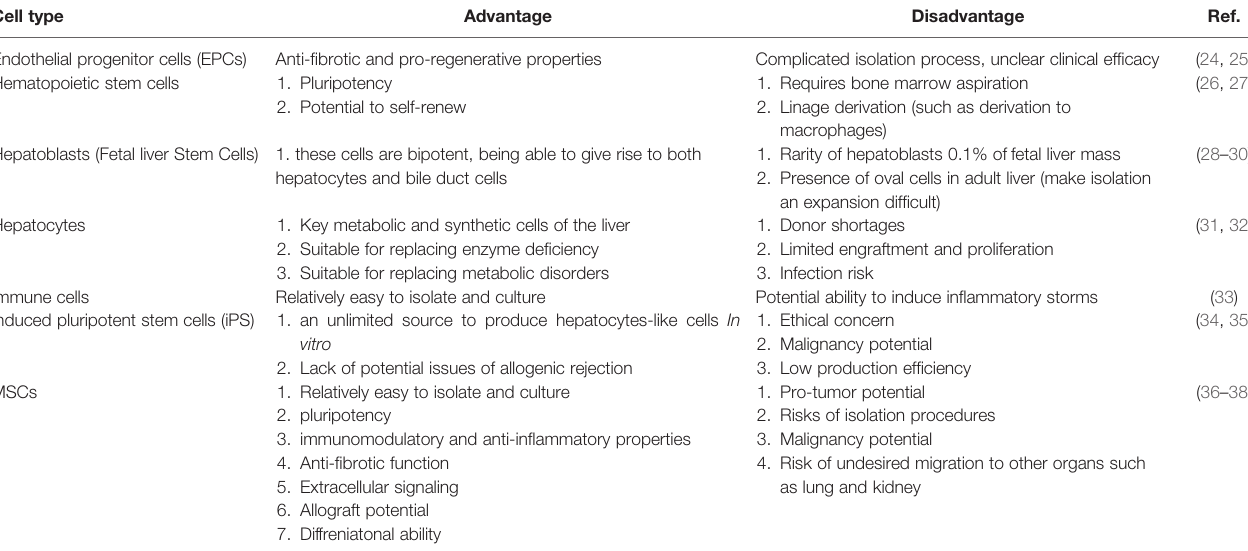
TABLE 1 | Advantages and disadvantages of each cell in therapeutic